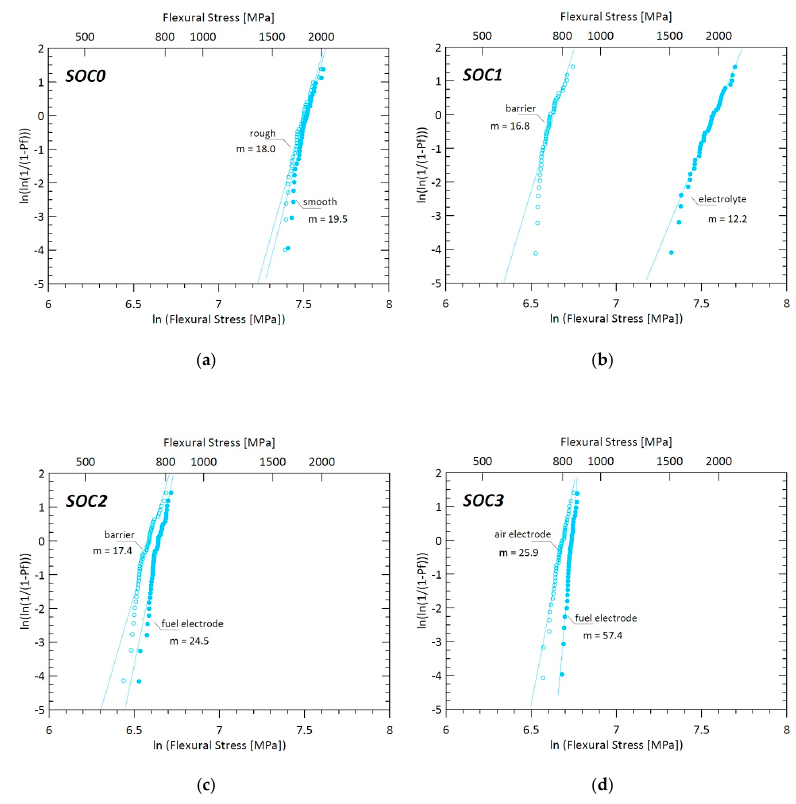
Figure 6. Weibull plots of the fracture stress distribution of the SOC0-SOC3 samples, obtained via ball-on-3-balls test. In each graph are represented two plots, one for each side of the sample under tension, with their respective Weibull modules. ( a ): Weibull plot for SOC0 ( b ): Weibull plot for SOC1 ( c ): Weibull plot for SOC2 ( d ): Weibull plot for SOC3.